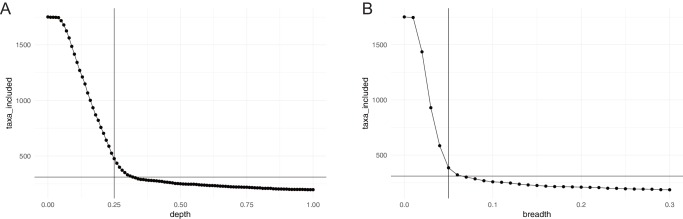
Horizontal (breadth) and vertical (depth) coverage cutoffs.To be considered in our study, a species had to meet three criteria in at least 10% of all considered samples: relative abundance >10−6; average vertical genome coverage (depth) ≥0.25 x; horizontal genome coverage (breadth) ≥5%. The panels show the number of taxa meeting the (A) depth and (B) breadth criterion alone, as a function of coverage. The chosen cutoffs and final number of taxa considered (310) are indicated.